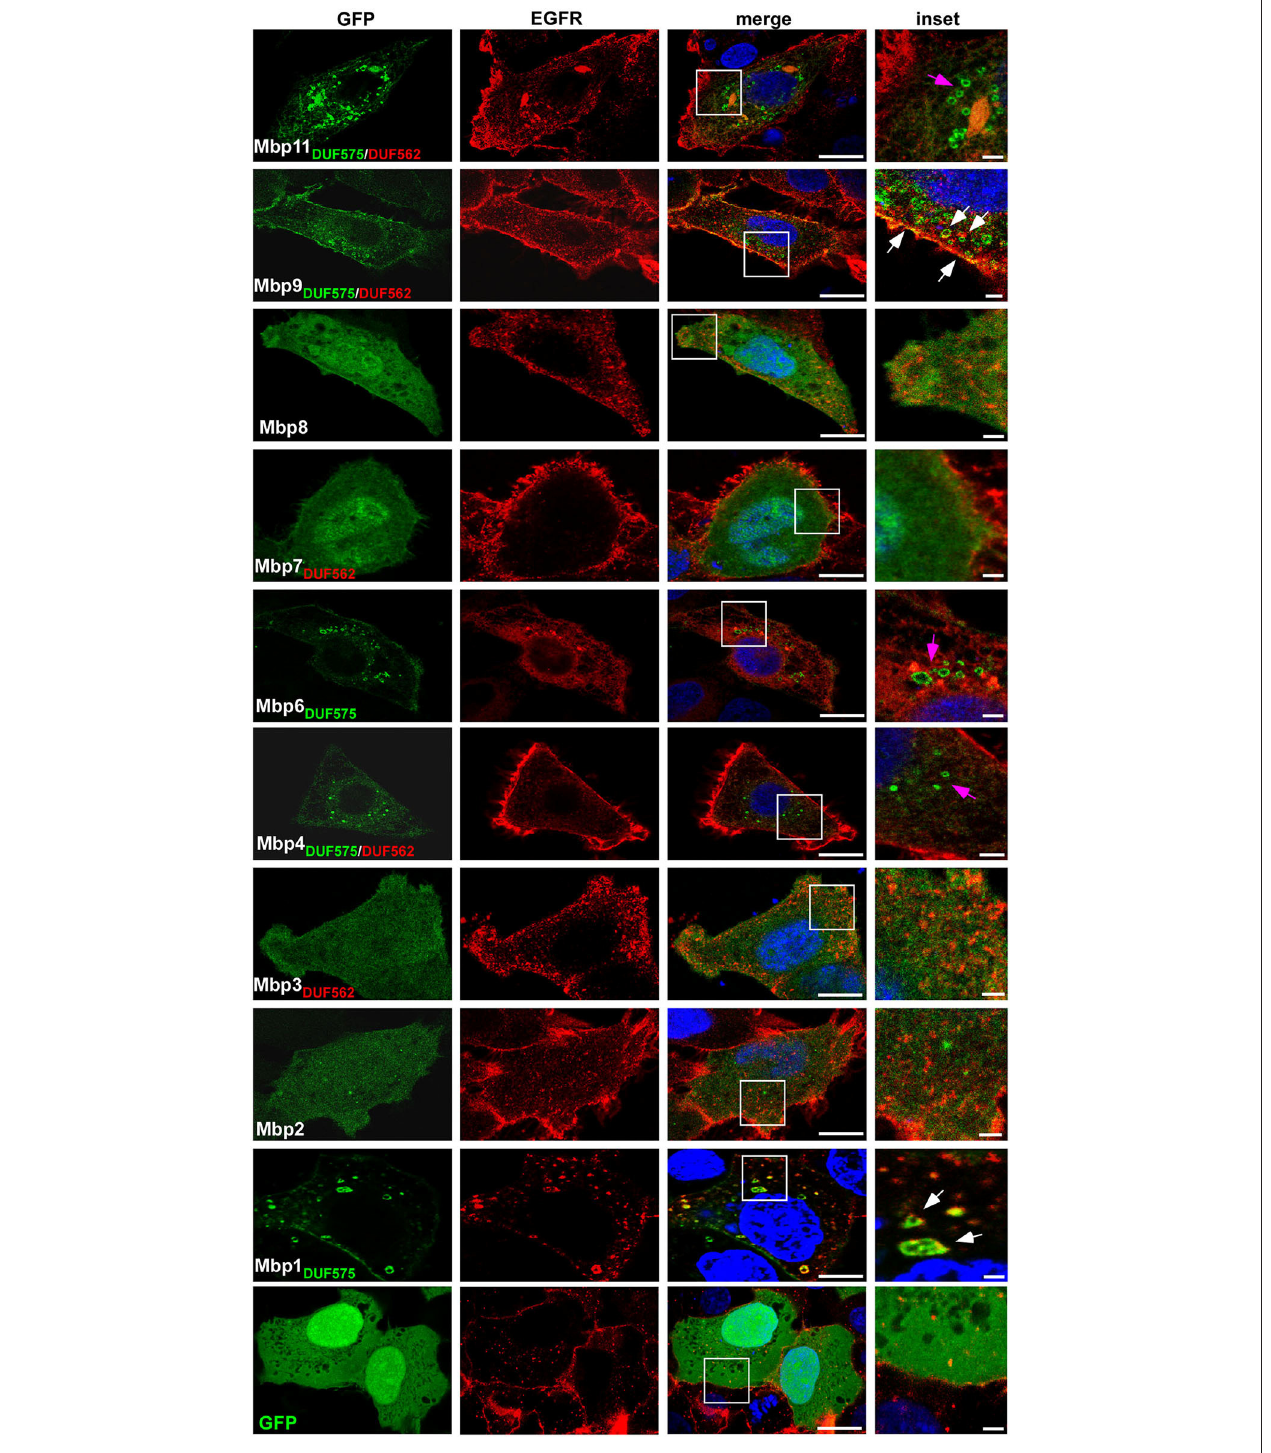
FIGURE 2 | Ectopic expression of cluster proteins reveal a DUF575-dependent localization to EGFR-positive endo-membranes in human cells. Confocal images of human epithelial cells transfected with GFP or nine predicted products of the GiD gene cluster mbp1 - mbp11 , each fused to GFP. Presence of the DUF domains are indicated in green and red. HEp-2 cells were transfected with the indicated GFP fusion proteins for 18h, fixed with 3% PFA and permeabilized with 100% methanol. Endogenous EGFR was visualized with an anti-EGFR antibody in combination with anti-rabbit Alexa594. The DNA was stained with Dapi (blue). White box is enlarged in insets. Bar: 10 µ m, Insets 1 µ m. White arrows indicate colocalization of EGFR and cluster proteins on vesicular structures or the plasma membrane, pink arrows indicate cluster proteins on vesicular structures showing no colocalization with EGFR. The images are representative for three different biological replicates ( n = 3).